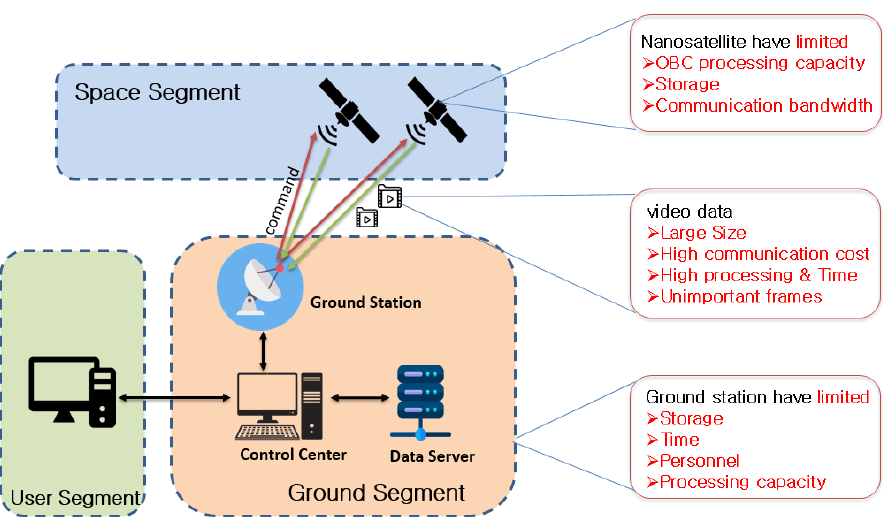
Figure 1. Nanosatellite video payload challenges. (Red line indicates the command sent to the nanosatellites, the green line indicates the download of the video payload data from the satellite to the ground, and the black line the transfer of the payload data in the ground system).